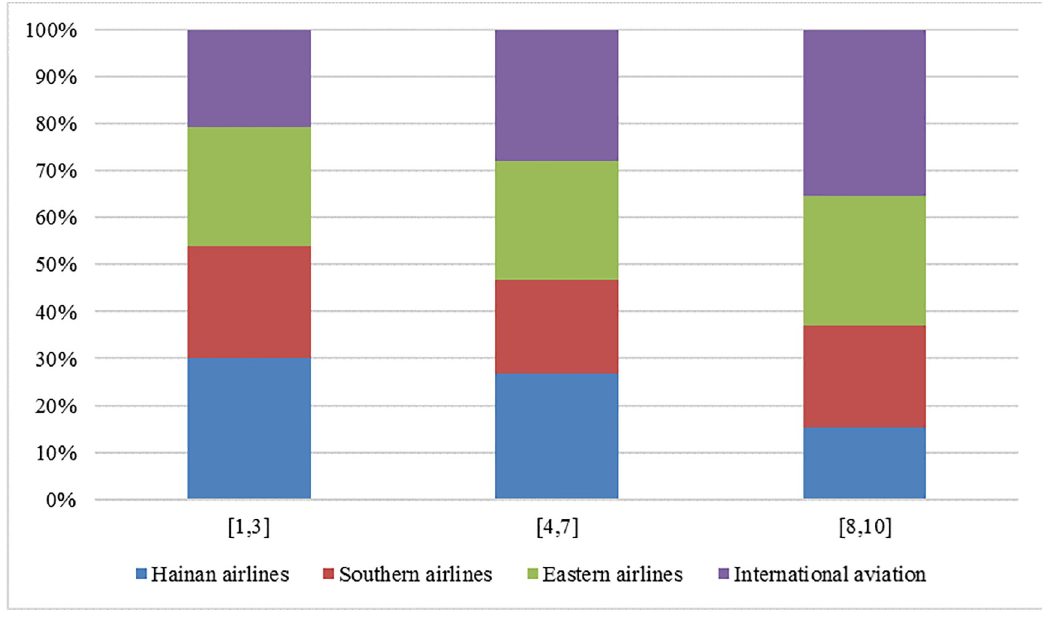
Fig 2. Bar chart of airline market